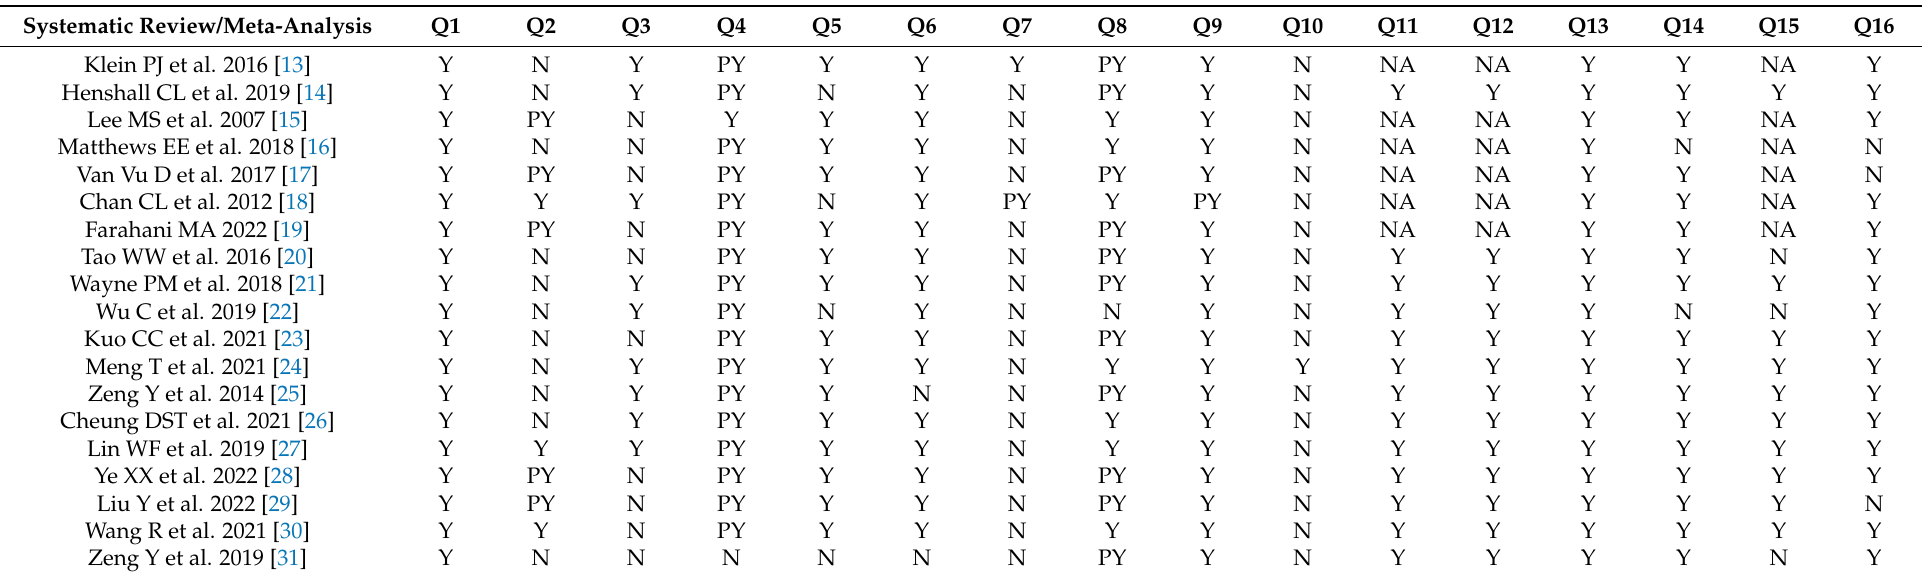
Table 3. Studies’ quality assessment according to the 16 criteria defined by